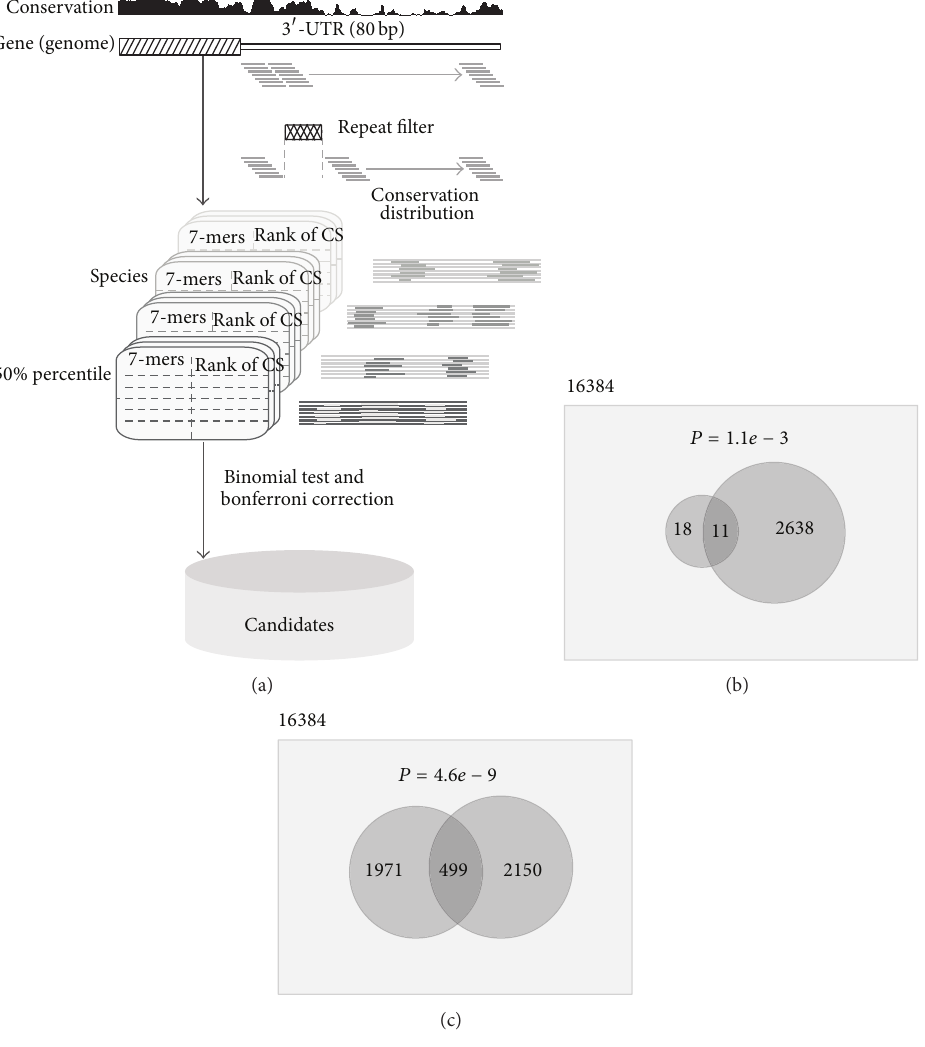
Figure 1: (a) Graphical representation of the miRNA seed prediction pipeline. Based on the defined 3 󸀠 -UTR from “Genbank Refseq” gene annotation, in genome sequences, we employed a sliding window method that used continuous 7 nt window with a step size of 1nt starting from the 5 󸀠 terminal of defined 3 󸀠 -UTR and calculated the WCS by the average conservation score in each window. We discarded sliding windows overlapped with repeat sequence. Then, we ranked all of these WCSs within each species and calculated the counts of conservation scores greater or less than the score of CS50, respectively. At last, for each type of 7-mers, we compared these two kinds of counts in all species to check whether the difference between them is significant using the binomial test followed by Bonferroni post hoc correction. We kept the 7-mer nucleotides as candidate miRNA seed if the conservation signal above background with 𝑃 value < 0.05. (b) Venn plot of known seeds (left circle) from a previous study and detected seeds (right circle). (c) Venn plot of known seeds from eukaryote (left circle) and detected seeds (right